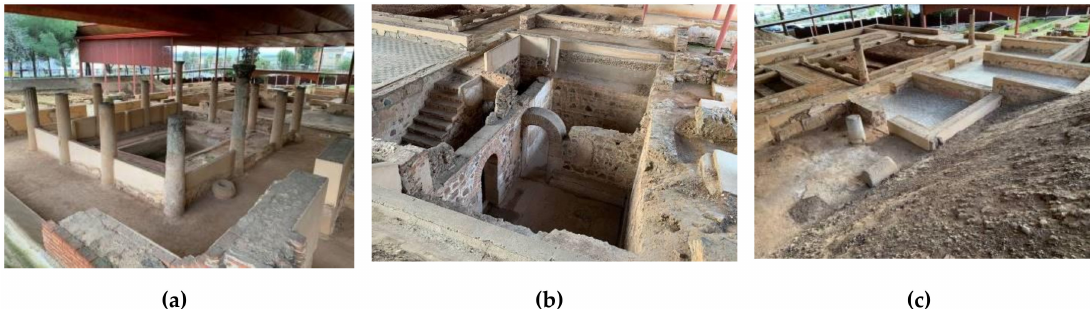
Figure 5. Work areas in the “Casa del Mitreo”: ( a ). Working area 1: Pond and Peristilium (left); ( b ). Working area 2: Underground rooms (center); and ( c ). Working area 3: Rooms with mosaic floors (right).